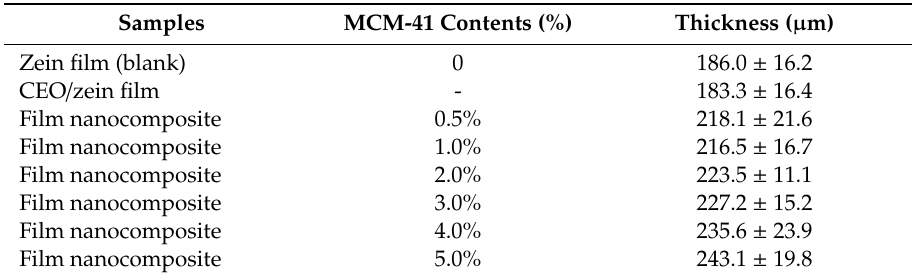
Table 2. Film thickness of the zein-based film.